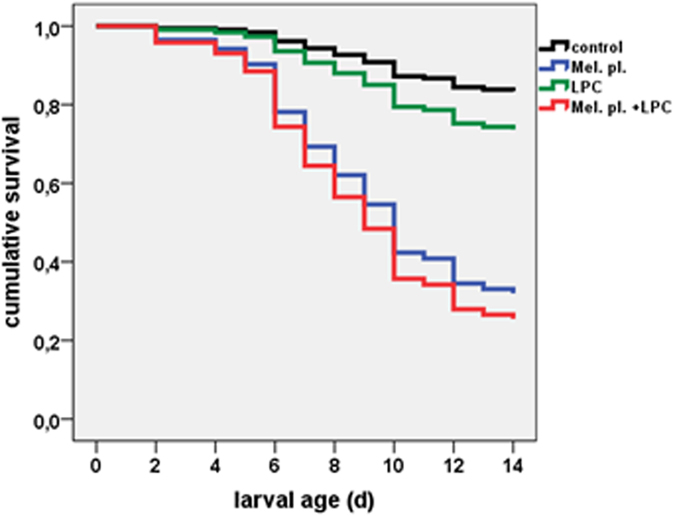
Cumulative survival rate of honeybee larvae.Control; fed with LPC (15 µg/d on day 1, 2 and 3); inoculated with M. plutonius bacteria and treated with LPC (15 µg/larva on day 1, 2, and 3) and larvae inoculated with M. plutonius without treatment. The observation period was 14 d; 2 replicates. Replicates: control (48/46), LPC (48/47), LPC + M. plutonius (48/48), M. plutonius (48/48).